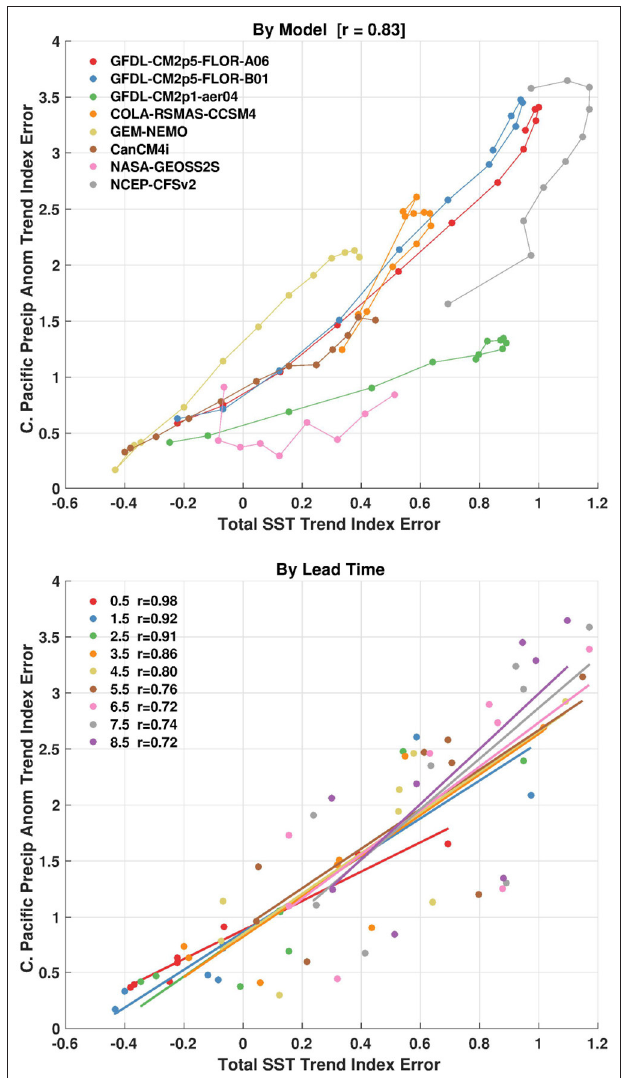
FIGURE 9 | (Top) Scatterplot of error in the linear trend of Central Pacific precipitation anomaly index on the y-axis and the error in the linear trend of the total sea surface temperature index on the x-axis. The lines connect the forecast lead times, with smaller errors generally associated with shorter lead times. (Bottom) Same as the top panel except also showing the least-squares fit for each forecast lead time. All forecast leads and NMME models are shown.The index errors are in units of degrees Celsius (SST) and millimeters/day (precip) change over January 1982 to December